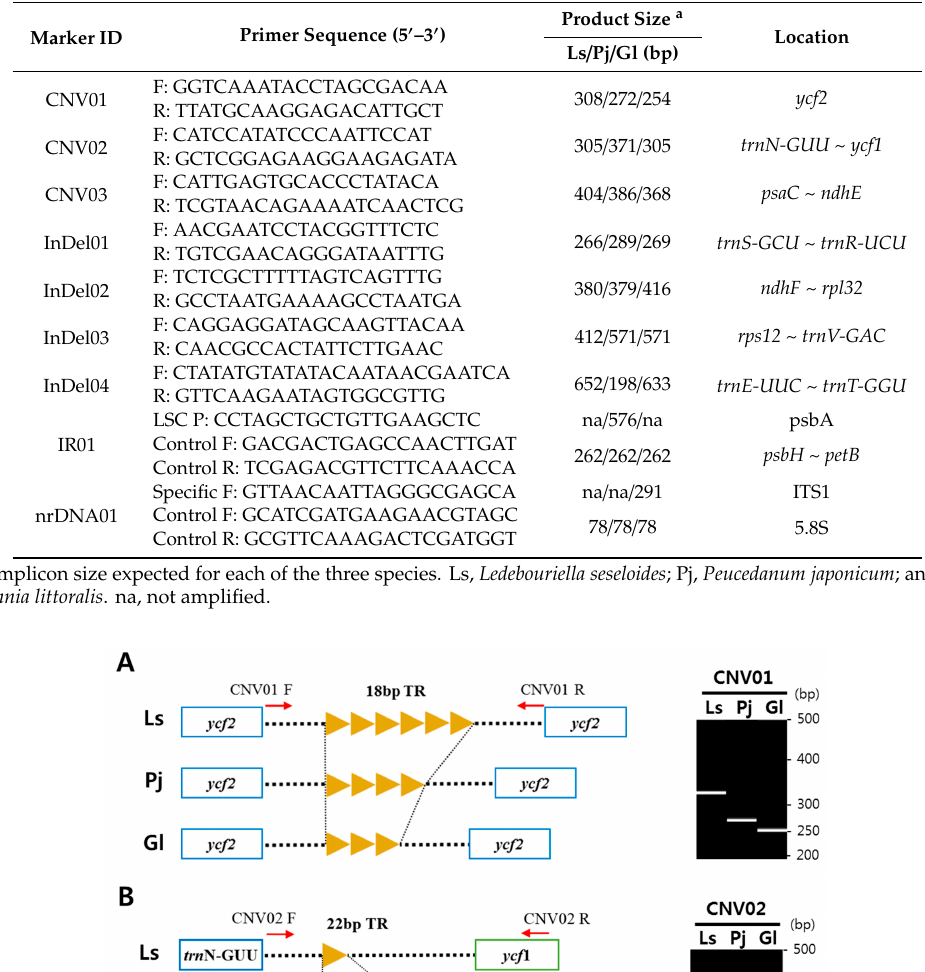
Table 3. Barcode markers developed in this study.